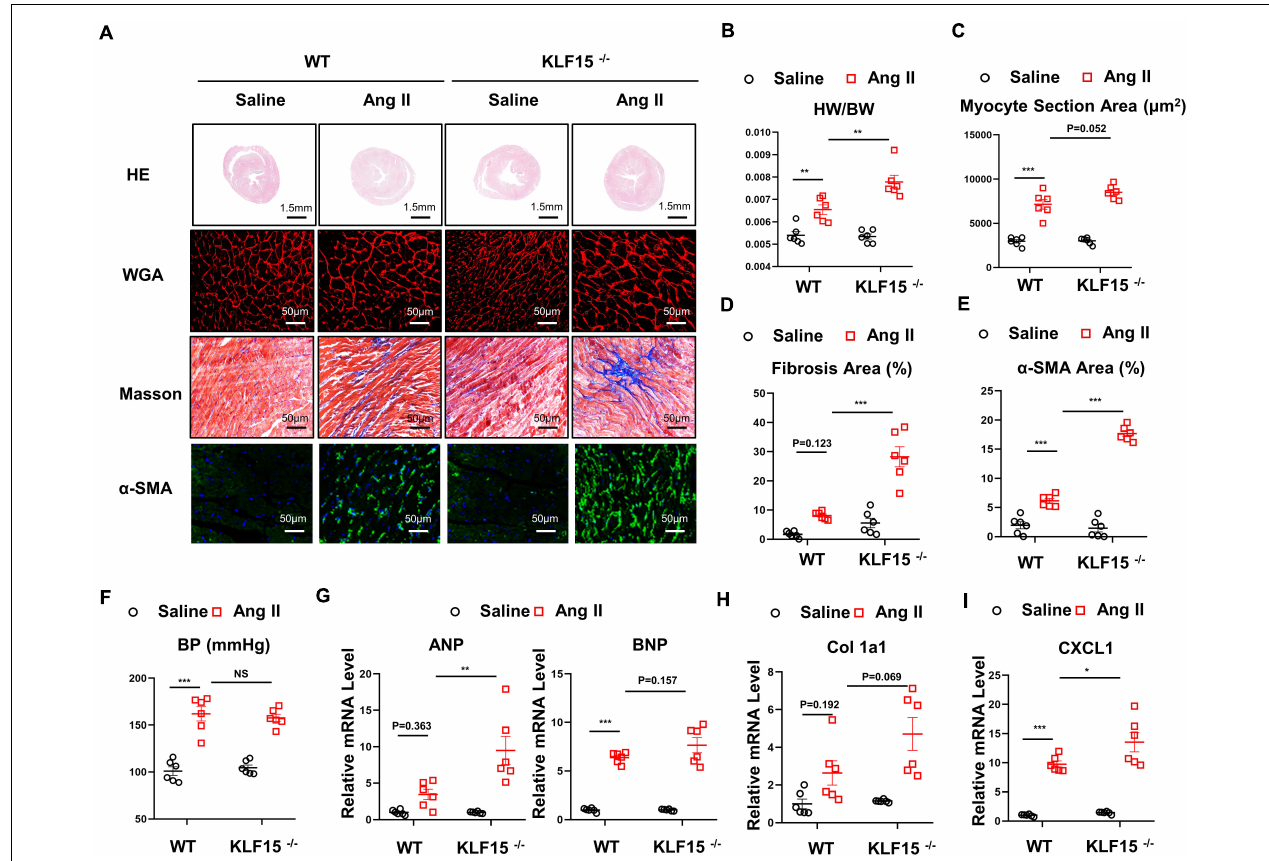
FIGURE 2 | Deficiency of KLF15 aggravated Ang II-induced cardiac remodeling. Wild-type (WT) mice and KLF15 knockout (KO) mice were infused with saline or Ang II for 14 days. (A) Representative heart size, WGA stain, Masson stain, and α -SMA immunofluorescence image. (B) Statistical analysis of heart weight/body weight ratio. (C) Quantification analysis of myocyte section area. (D) Quantification analysis of fibrotic area measured by Masson stain. (E) Quantification analysis of α -SMA positive area measured by immunofluorescence. (F) Statistical analysis of blood pressure. (G–I) qPCR analysis of mRNA levels of ANP, BNP, Collagen 1a1, and CXCL1. * P < 0.05, ** P < 0.01, and *** P <